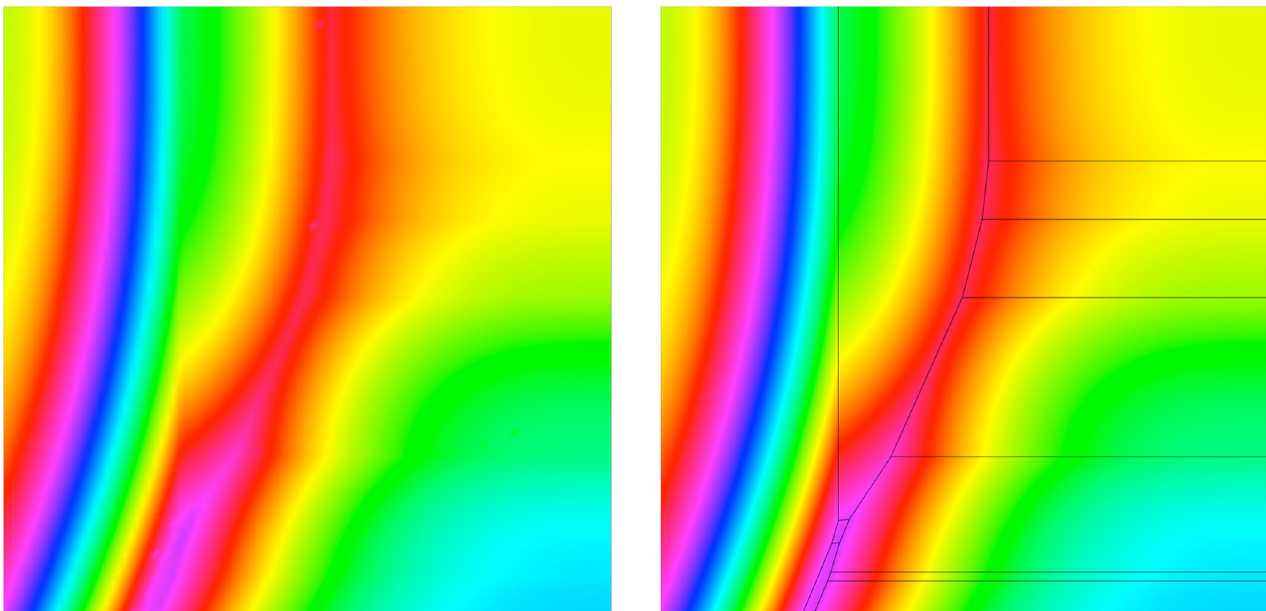
FIG. 12 Contours of optimal packing density ϕ for the 523 family, numeric (left) versus analytic (right). The color gradient {blue, magenta, red, yellow, green, cyan, and blue} represents the ϕ gradient f ϕ − 3 ϕ þ 2 ; ϕ þ 3 ; yellow contours occur at ϕ ¼ f 8 60 60 g